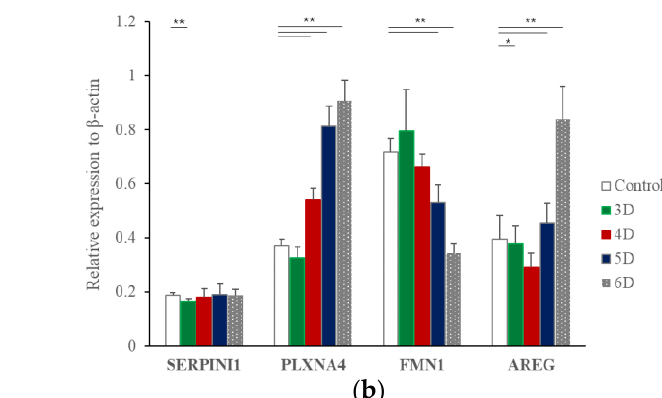
using real-time polymerase chain reaction. Column heights correspond to mean values and error bars to standard deviations ( n = 3).